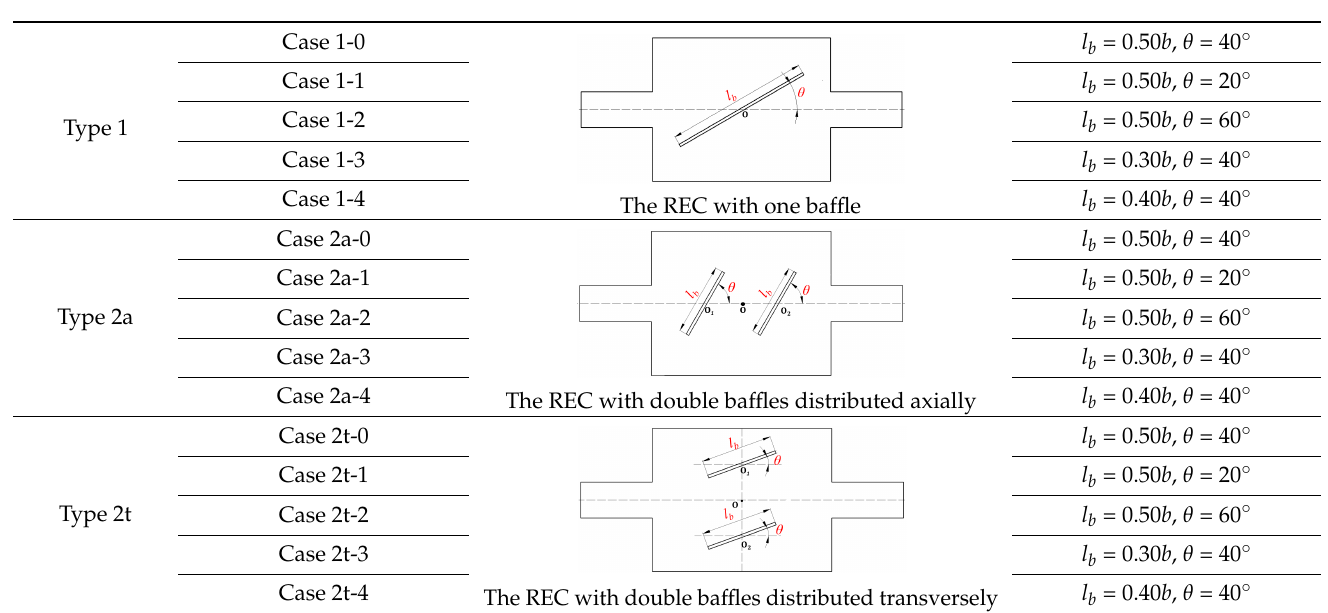
Table 3. The geometries of the RECs with different baffle configurations.